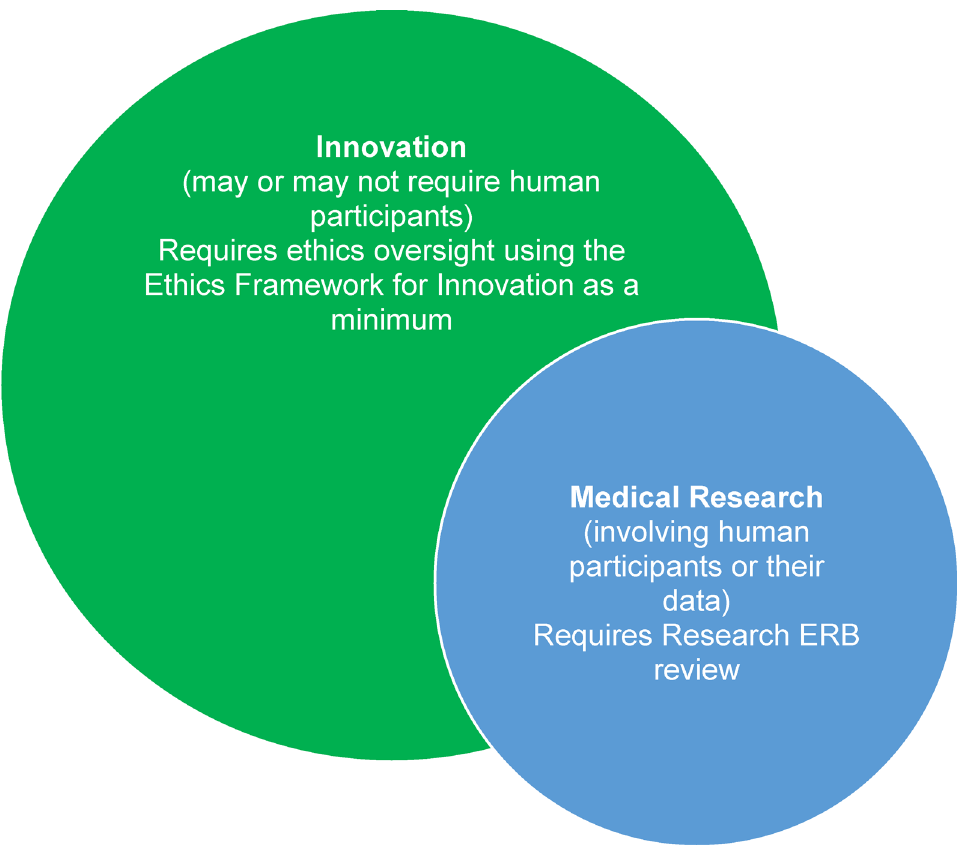
Fig 1. Relation between humanitarian innovation and medical research and their oversight in